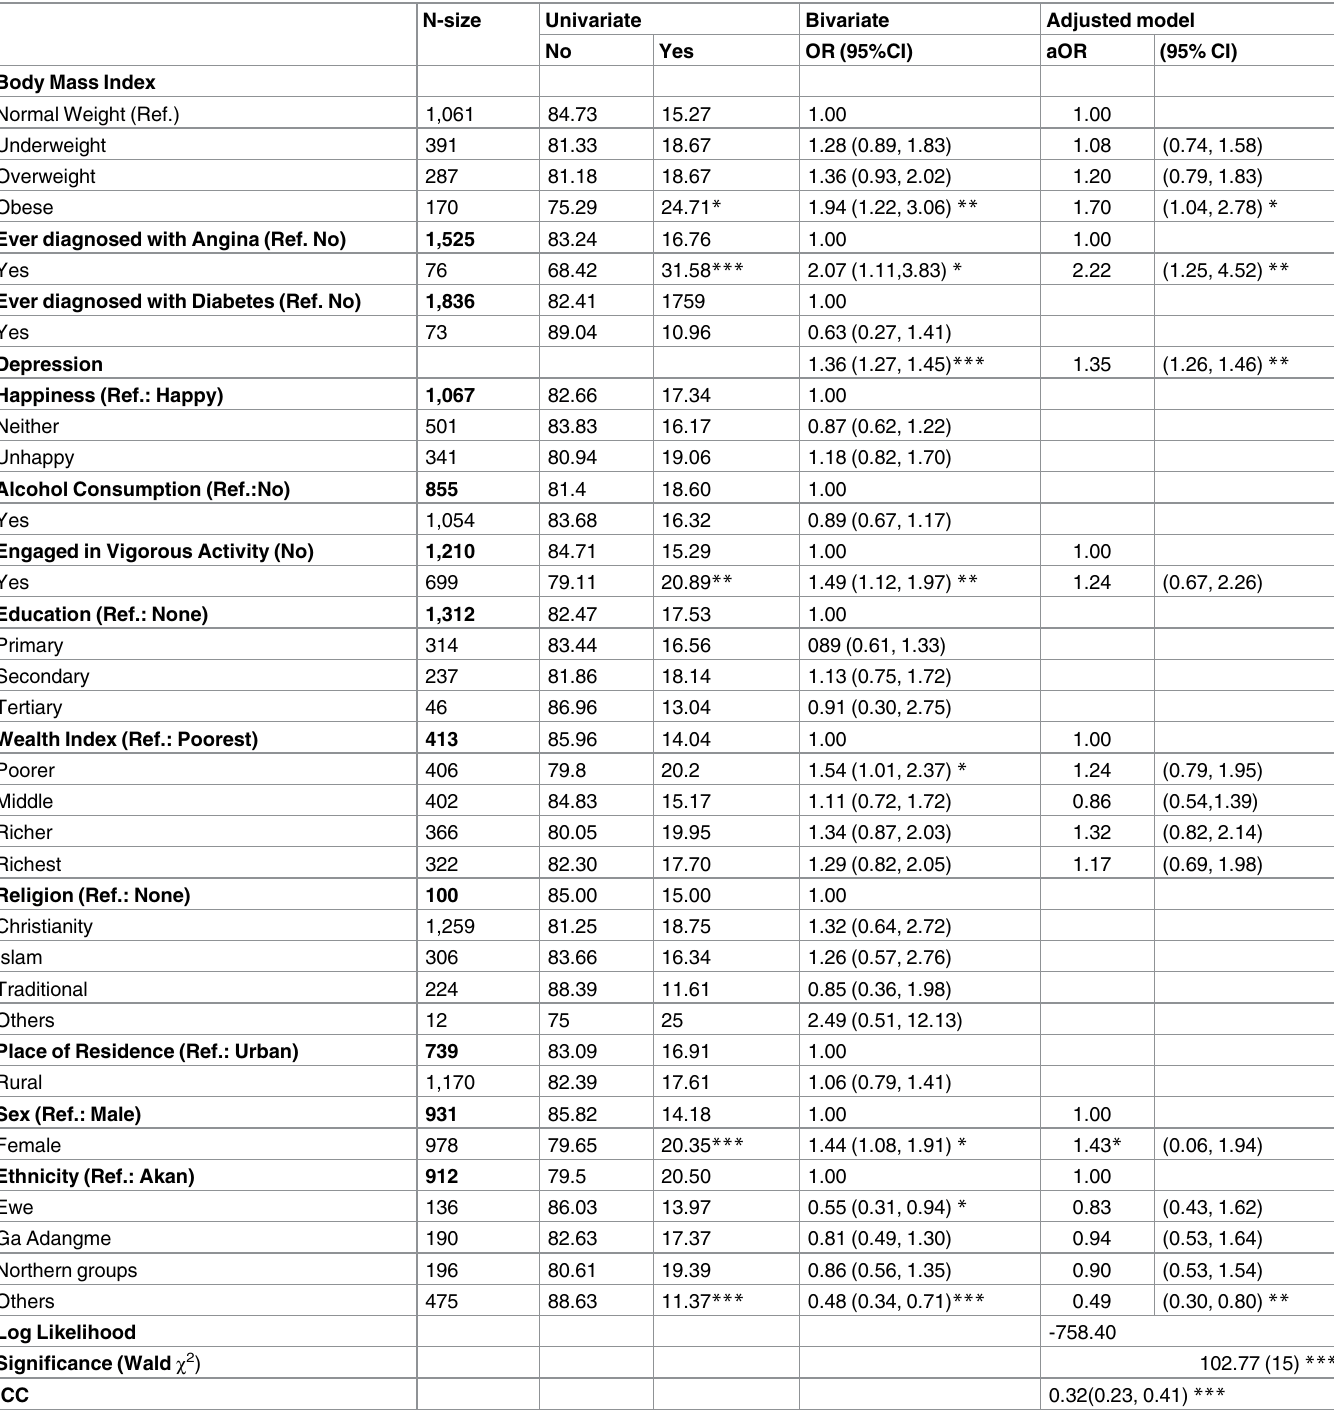
Table 3. Univariate, bivariate and adjusted results of generalized linear mixed effect logit model of arthritis on elderly obesity. N-size Univariate Bivariate Adjusted model No Yes OR (95%CI) aOR (95% CI) Body Mass